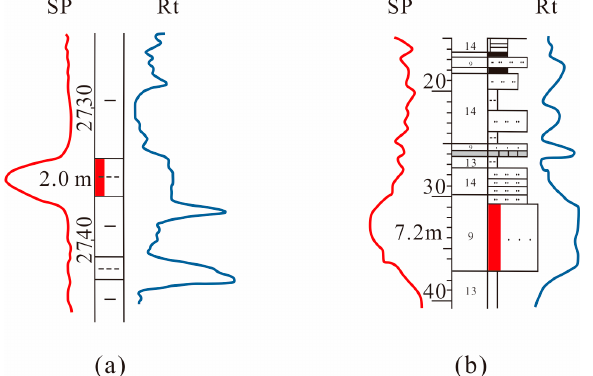
Figure 3. Well logs of beach-bar sand. ( a ) Cross section of beach sand in Well Gao891; ( b ) cross section of bar sand in Well